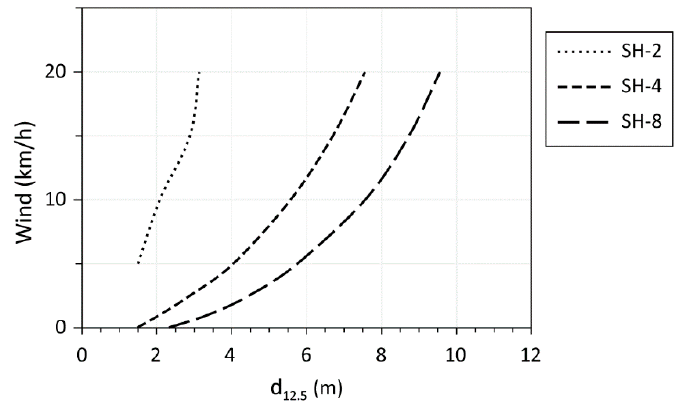
Figure 10. Safe separation distances as a function of wind speed at Low MC of live fuel (L2) and variable MC of dead fuel (D2, D3, D4) for each fuel model of GS category: ( a ) GS-1, ( b ) GS-2, ( c ) GS-3.